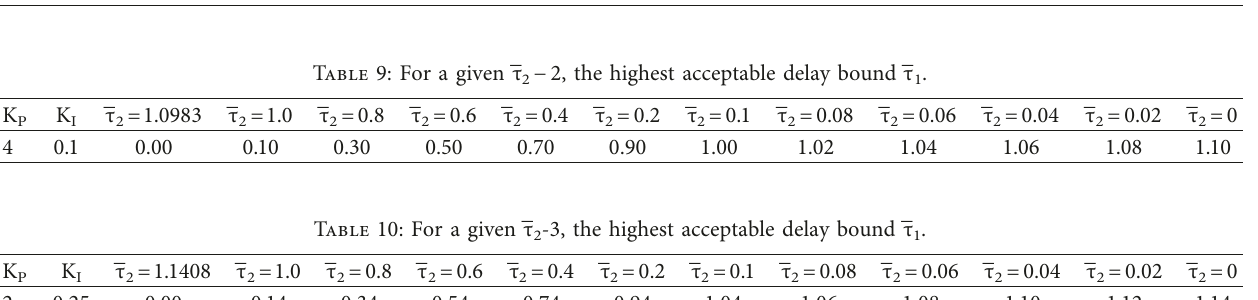
2 -3, the highest acceptable delay bound τ